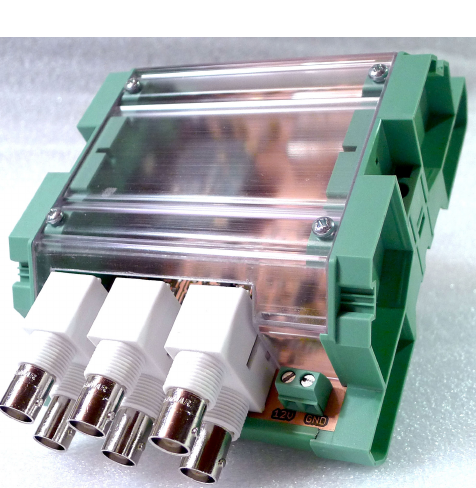
Figure 3. Structure of the wireless sensor system.